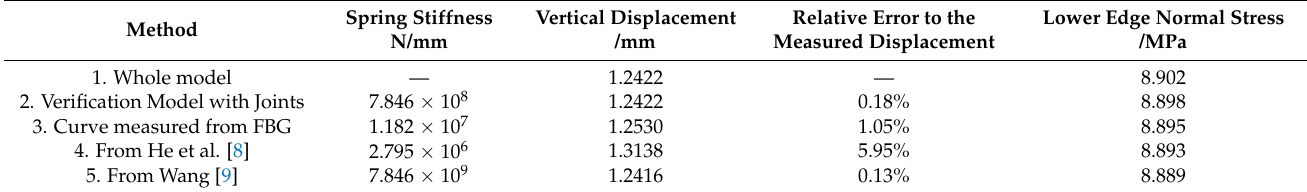
Table 4. Results at midspan of girder specimens under the action of 200